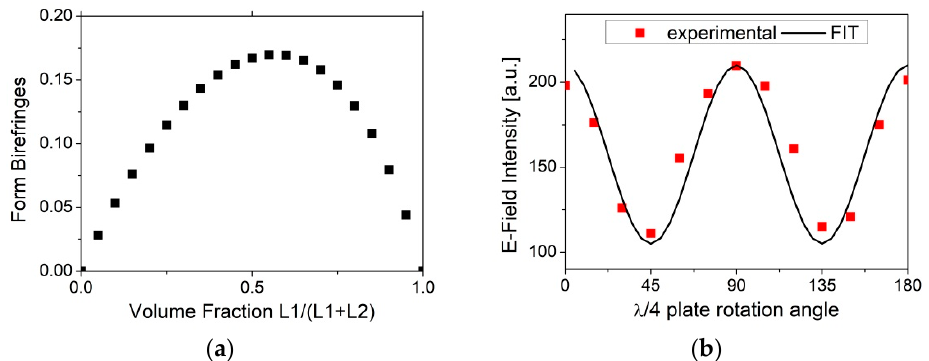
Figure 1. ( a ): Form birefringence vs. dielectric volume fraction calculated using Equations (1) and (2). ( b ): Plot of the E-field intensity of the manufactured λ /4 plate device under rotation around the THz beam propagation axis, with 15° steps. The solid curve represents the transmittance for an ideal λ /4 plate (see text).